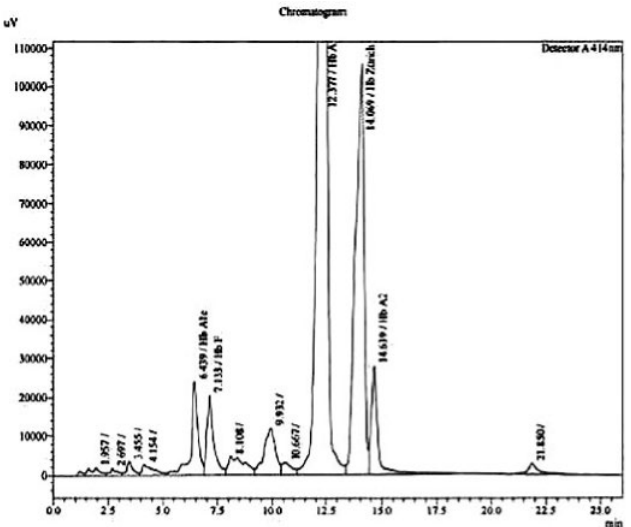
Figure 1 The patient’s blood smear with bite and blister cells (upper) and the Brilliant Cresyl Blue stains showing Heinz inclusion bodies